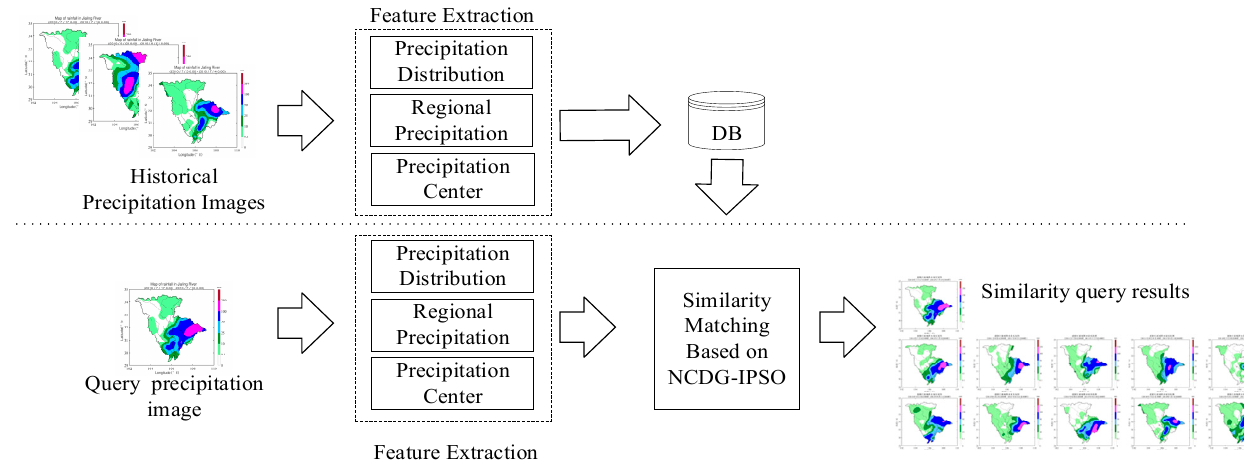
Figure 2. The process flow of precipitation image searching.